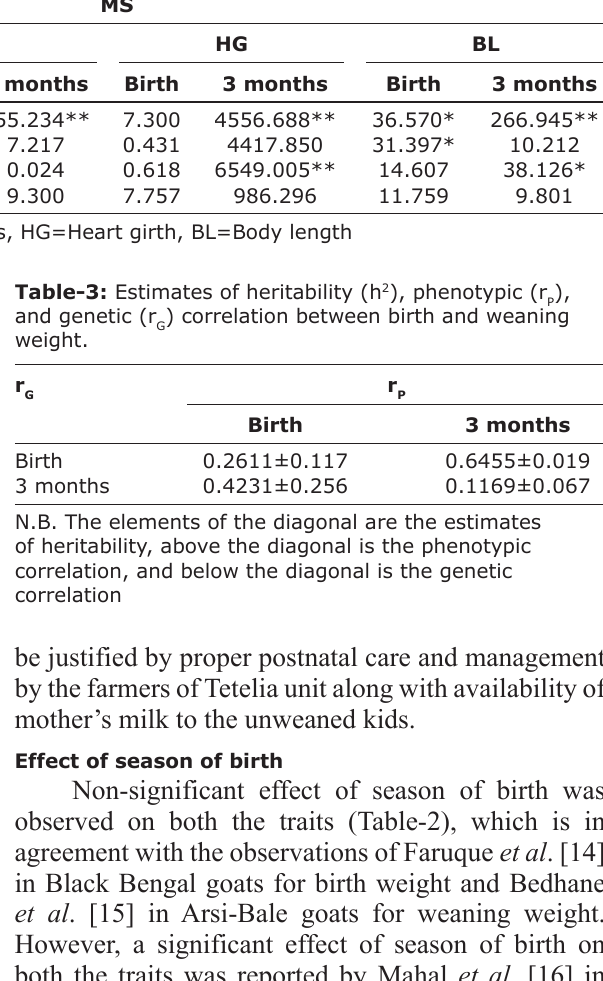
Table-2: Least squares analyses of variance for body weight, height at withers, heart girth, and body length. Sources of df variation